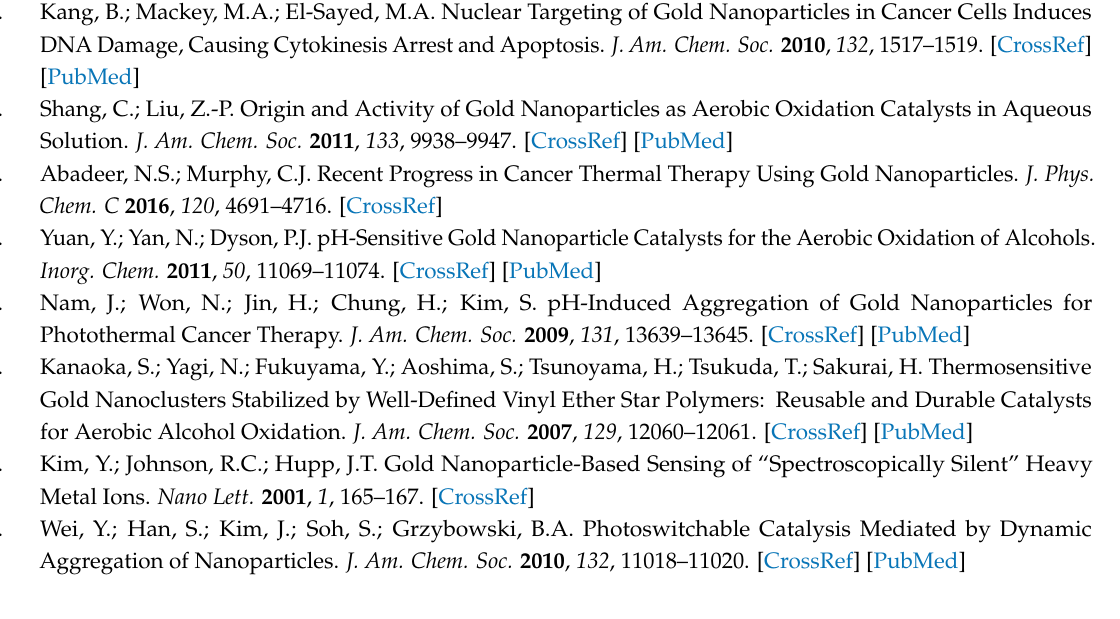
Figure S1: TEM images of AuNPs, Table S1: Hydrodynamic diameter and Zeta potential of AuNPs before and after MUA functionalization, Figure S2: UV-VIS spectra of MUA functionalization AuNPs with diameters of 5 nm, 13 nm, and 45 nm, Figure S3: UV-VIS absorption spectra of AuNP-MUA recorded at acidic and basic pH values. Figure S4: UV-VIS absorption spectra of AuNP-MUA recorded at different pH values varied from 9 to 3, Figure S5: Control experiment to show that ODA facilitates the phase transfer of AuNP-MUA, Figure S6: pH-triggered reversible phase transfer of AuNP-MUA studied using UV-VIS spectroscopy, Figure S7: The onset of phase transfer of AuNP-MUA from aqueous to CHCl3 phase, Figure S8: Time-resolved UV-VIS spectra for catalytic reaction of AuNPs as a function of MUA surface coverage, Figure S9: TGA curve for AuNP-MUA, Figure S10: Ability to recover the AuNPs functionalized with MUA different surface coverages, Figure S11: Fitting the absorbance data to pseudo-first-order reaction